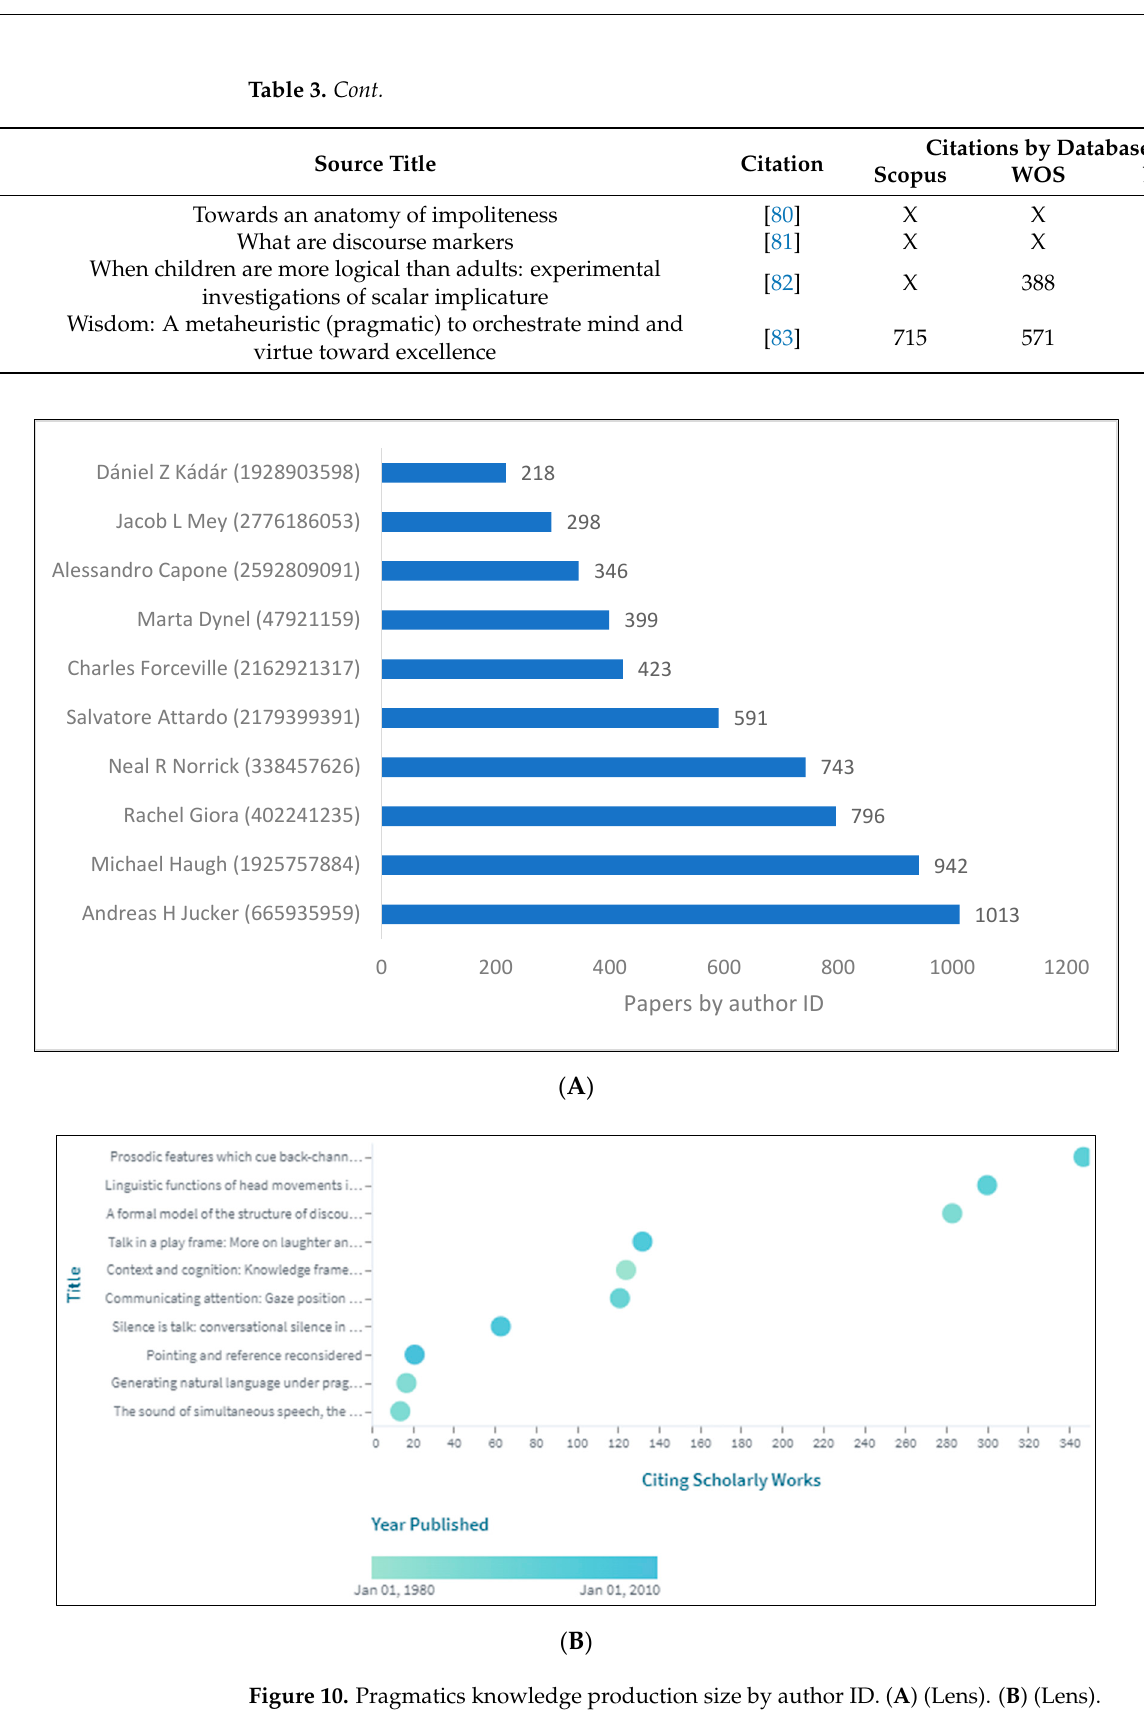
Figure 10. Pragmatics knowledge production size by author ID. ( A ) (Lens). ( B ) (Lens). Table 3. Top cited documents of pragmatics based on citation reports from Scopus, WOS and Lens. As a way to make this more tangible, we created three visual maps with the help of the VOSviewer (Figure 11A–C). An illustration of the co-citations by source is